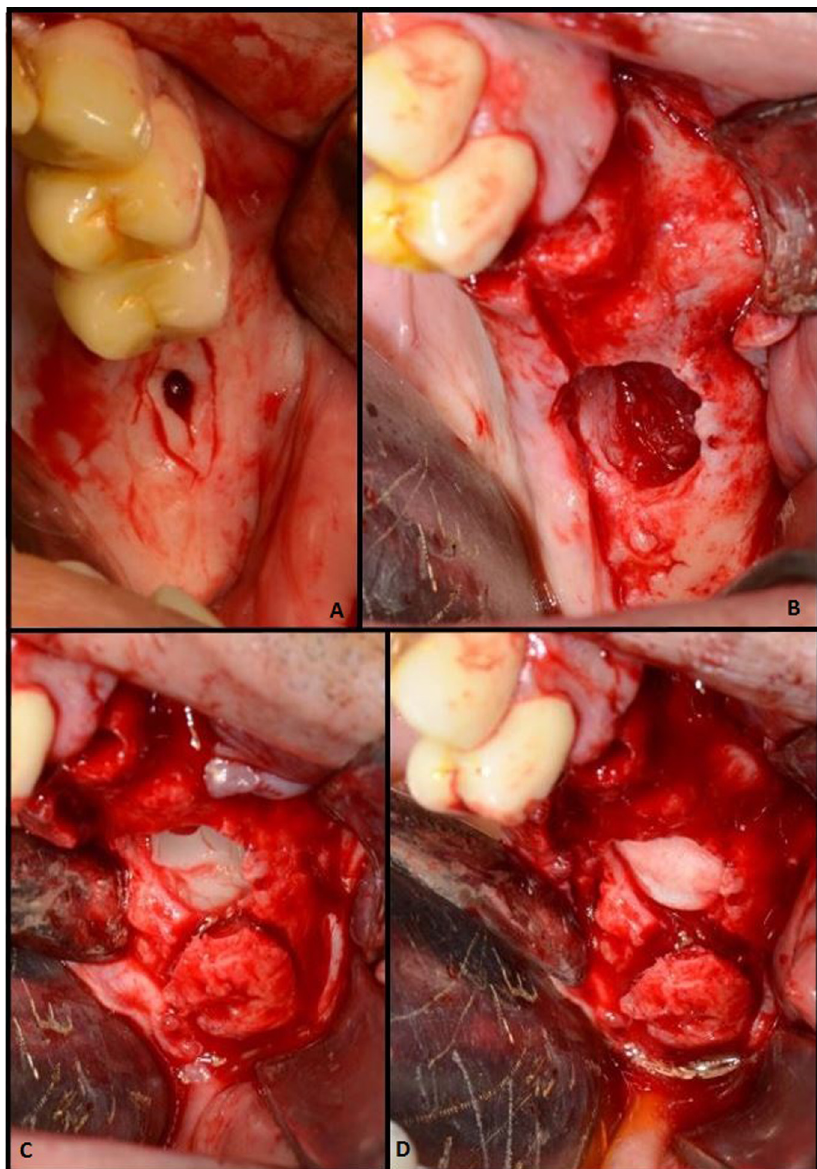
Fig. 2. (A) Incision line of the fi stulectomy. (B) Mucosal detachments. (C) Graft modeling and Placement of PRF to seal the sinus mucosa. (D) Placement of the collagen